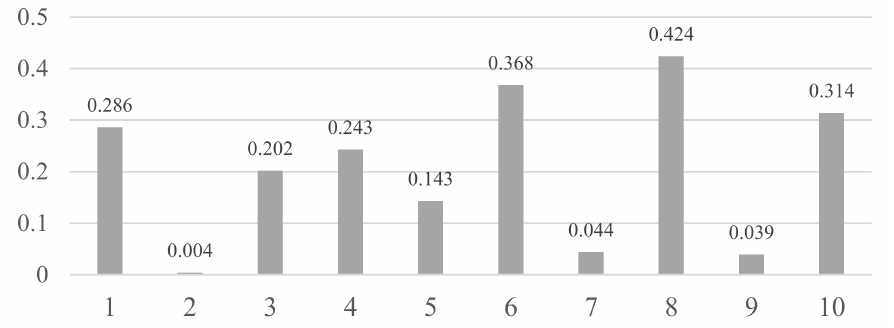
Figure 8. Error rate of each activity.